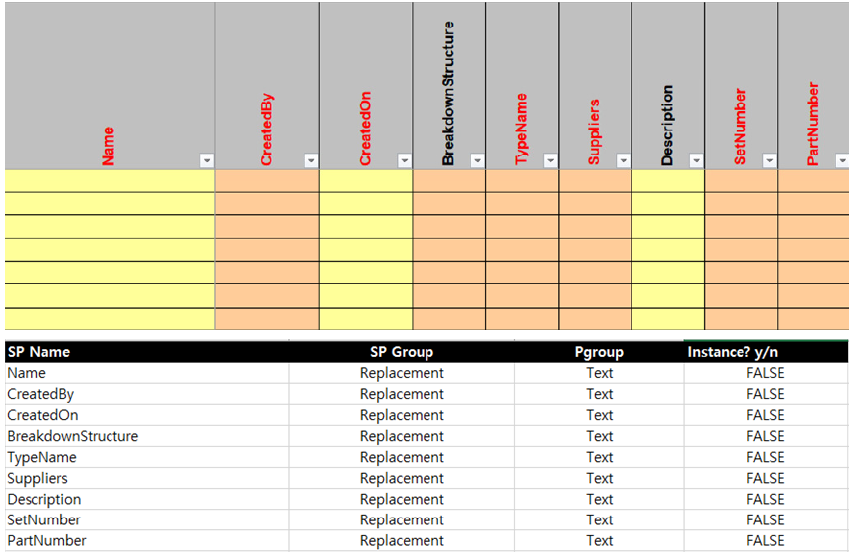
Figure 13. Reconfigured port COBie spreadsheet in order for creating shared parameters.